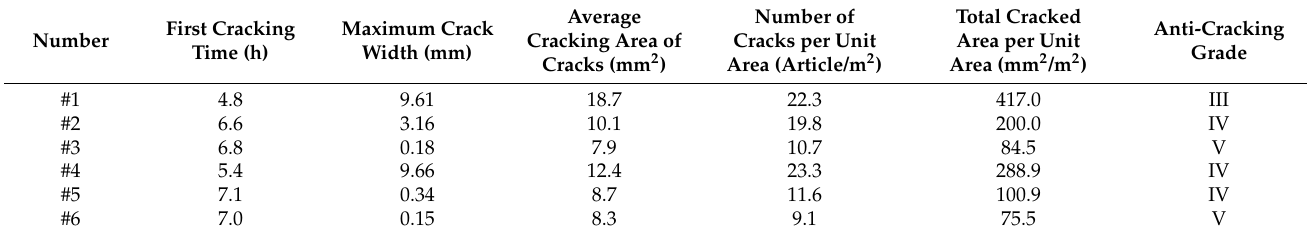
Table 3. Early cracking resistance test results of benchmark concrete of different strength grades and